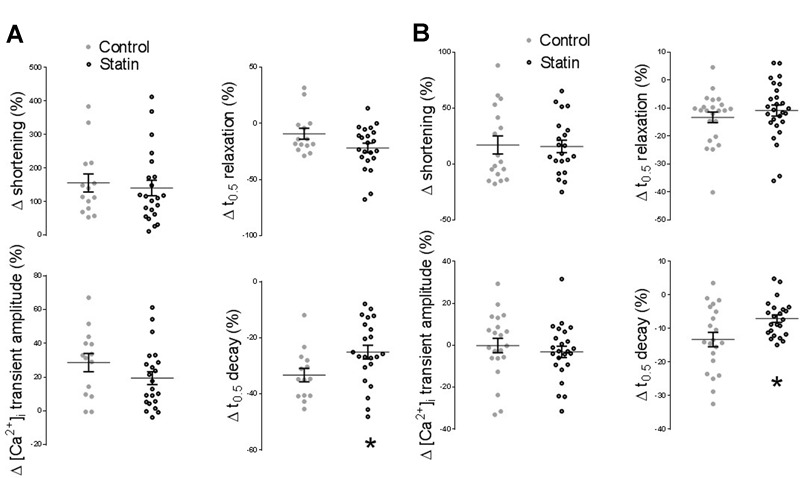
Effect of statin treatment on the response to β-adrenoceptor (AR) stimulation. (A) Percentage change from baseline in amplitude/kinetics of the [Ca2+]i transient and shortening in response to β1-AR stimulation with 100 nM isoprenaline in the presence of 100 nM ICI 118,551 (n = 14–22 cells from 3 to 4 animals per group). (B) Percentage change from baseline in amplitude/kinetics of the [Ca2+]i transient and shortening in response to β2-AR stimulation with 10 μM zinterol in the presence of 300 nM CGP20712A (n = 23–28 cells from 4 animals per group). Plots show mean ± SEM. ∗P < 0.05 vs. saline-treated group, Student’s t-test.